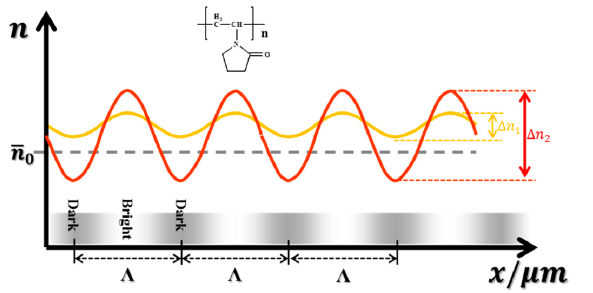
Figure 7. Schematic diagram of the internal refractive index distribution of photopolymer. n 0 is the average refractive index of the unexposed photopolymer material; Λ is the grating period; the yellow line represents the photopolymer without glycerol; the red line represents the photopolymer with glycerol.